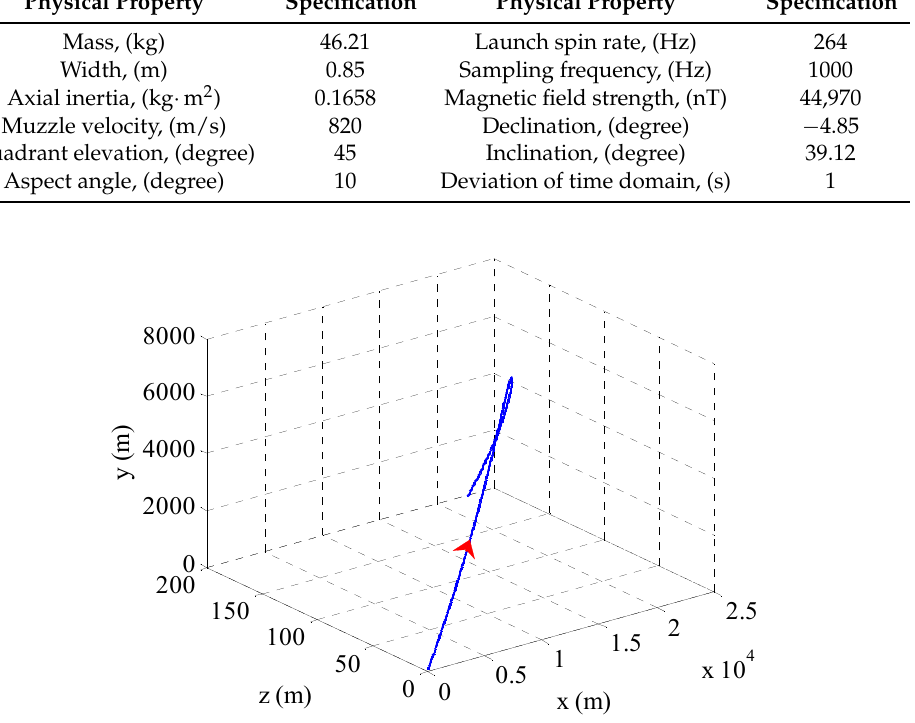
Figure 10. 3D trajectory path of projectile in ballistic flight.